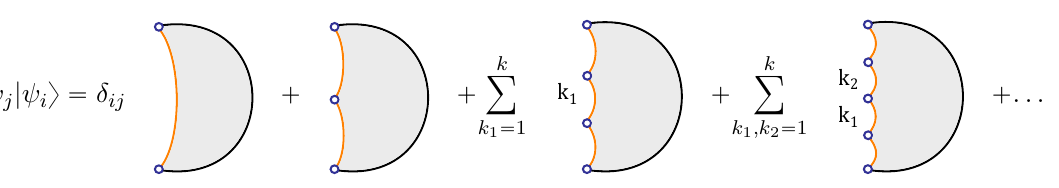
Figure 2 . In the model of section 2 the off-diagonal terms come from EOW interactions where boundary particles can change flavor, the associated coupling constants depend on γ and C 0 and the summations are over different flavors of the intermediate boundary particles (external flavor labels i and j were left